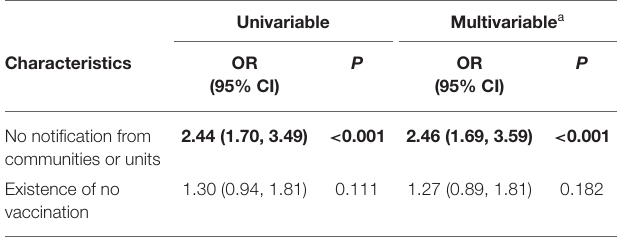
Univariable Multivariable a